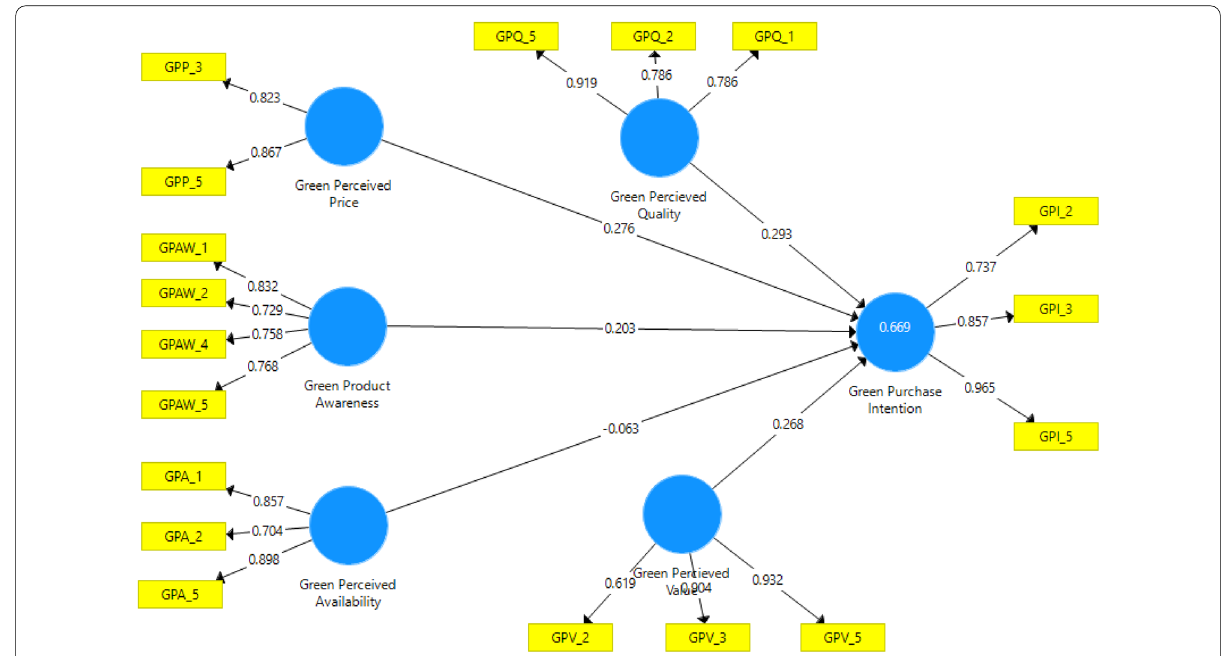
Fig. 1 Tested research